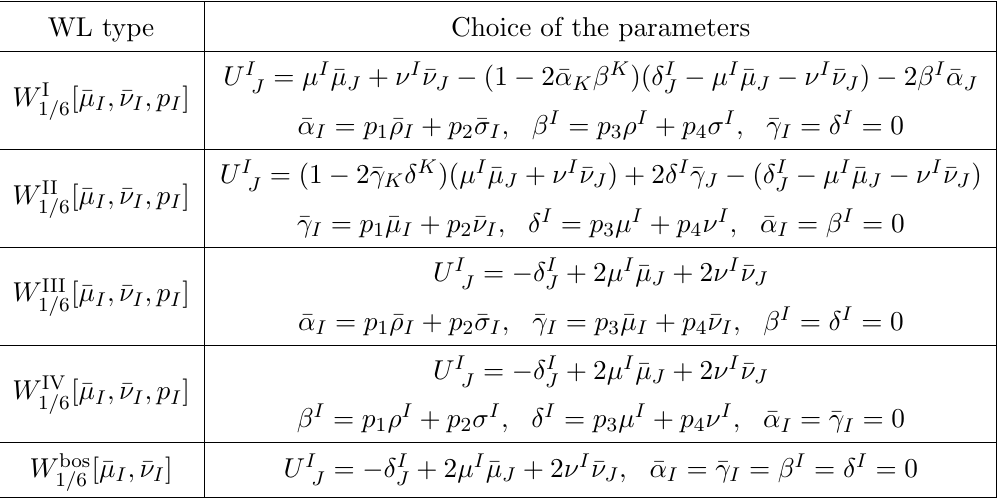
Table 1 . The four types of fermionic WLs and the bosonic 1/6 BPS WL in ABJ(M) theory.